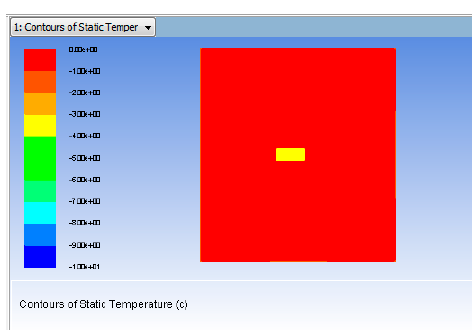
Figure 6. Temperature contour.